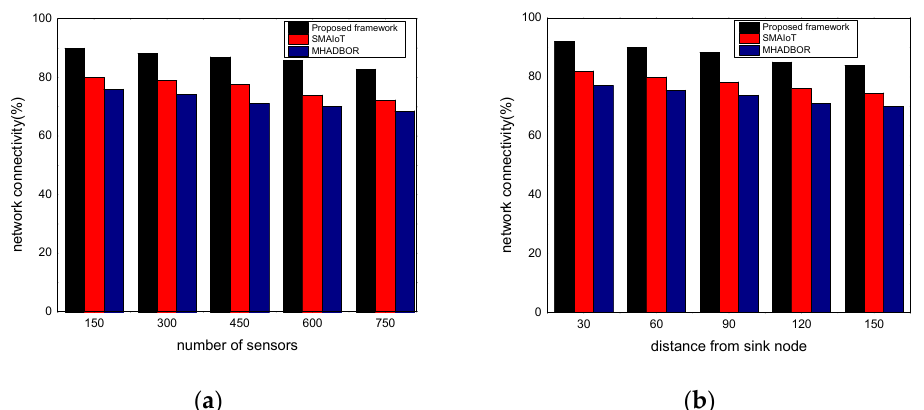
Figure 9. ( a ) Network connectivity with varying sensors and ( b ) Network connectivity with varying distance.